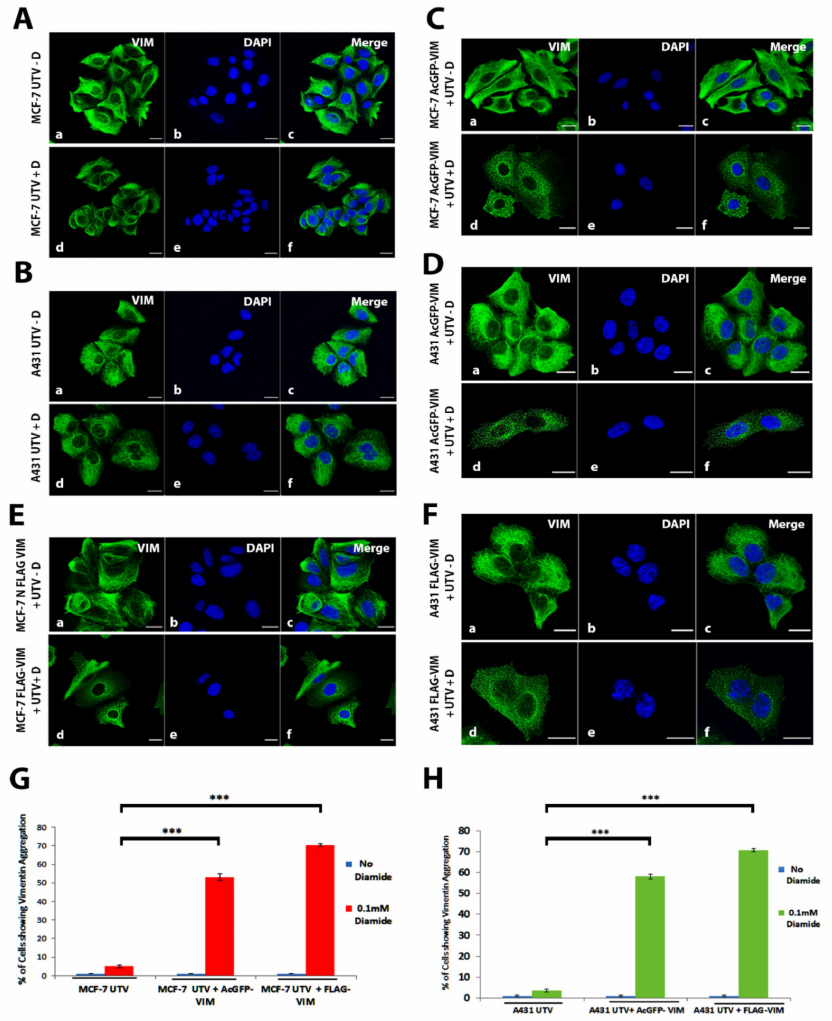
(green). Nuclei were stained with DAPI in blue and overlapping of all colours is shown as ‘Merge’. Leica DM4000B Epi-fluorescence microscope was used for visualisation and DFC350 camera was used for image recording. (scale bar = 20 µ m). Note that vimentin aggregation has been completely reversed by UTV and filaments can be seen in green colour ( a , i ). The western blot analysis shows a 1:1 ratio between AcGFP-tagged and untagged vimentin (Figure S5).